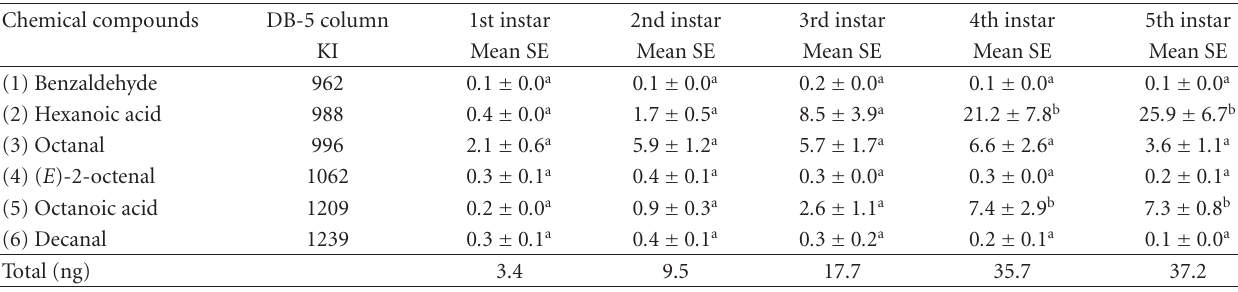
Table 1: Identification and quantification (ng) of compounds present in Thaumastocoris peregrinus (Heteroptera: Thaumastocoridae) exuviae. Di ff erent letters for each compound indicate significant di ff erences between instars (KI: Kovats Index; SE: standard error). Statistical comparisons: Kruskal-Wallis rank sum test followed by a nonparametric multiple comparisons test ( P > 0 .